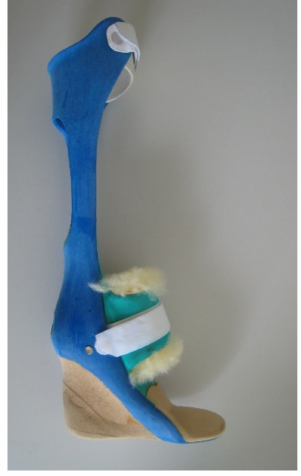
Figure 2. Example of an ankle foot orthosis designed for a severe equinus deformity (rigid version). The added heel shows the compensation for the gastosoleus